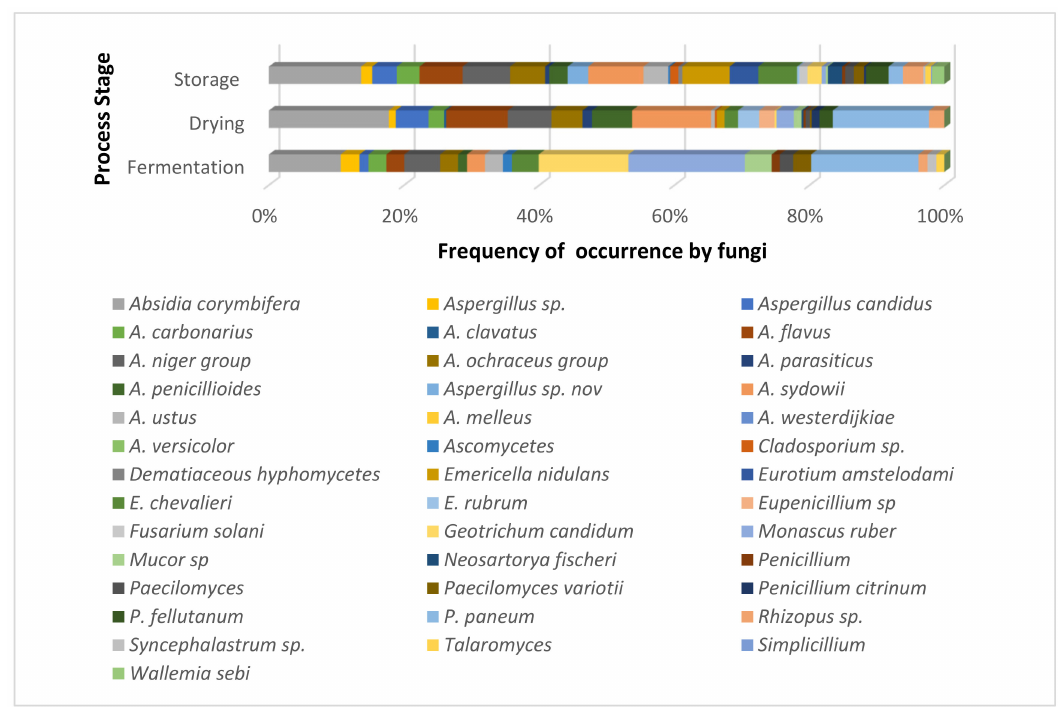
Figure 2. Main fungi found in the fermentation, drying, and storage stages during cocoa processing carried out by farmers on the farm